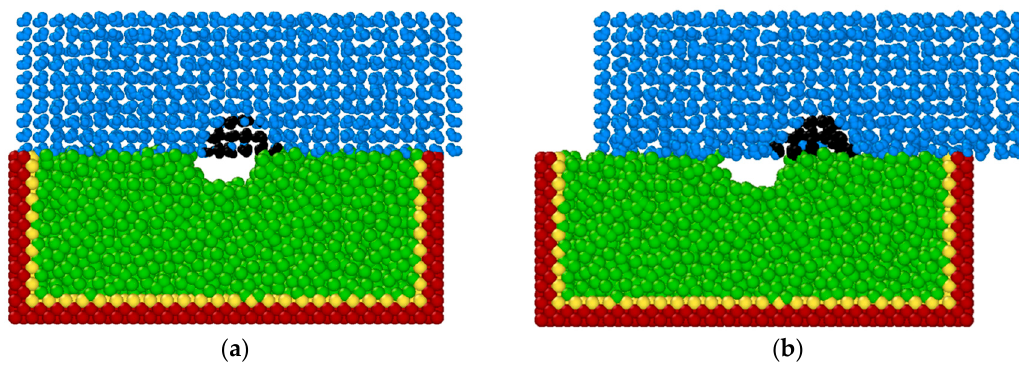
Figure 15. MD Simulation Snapshot Showing Thermal Blanket Formation during LA-LBMM Process in Dynamic Mode ( a ) Initial Stage ( b ) Final Stage.